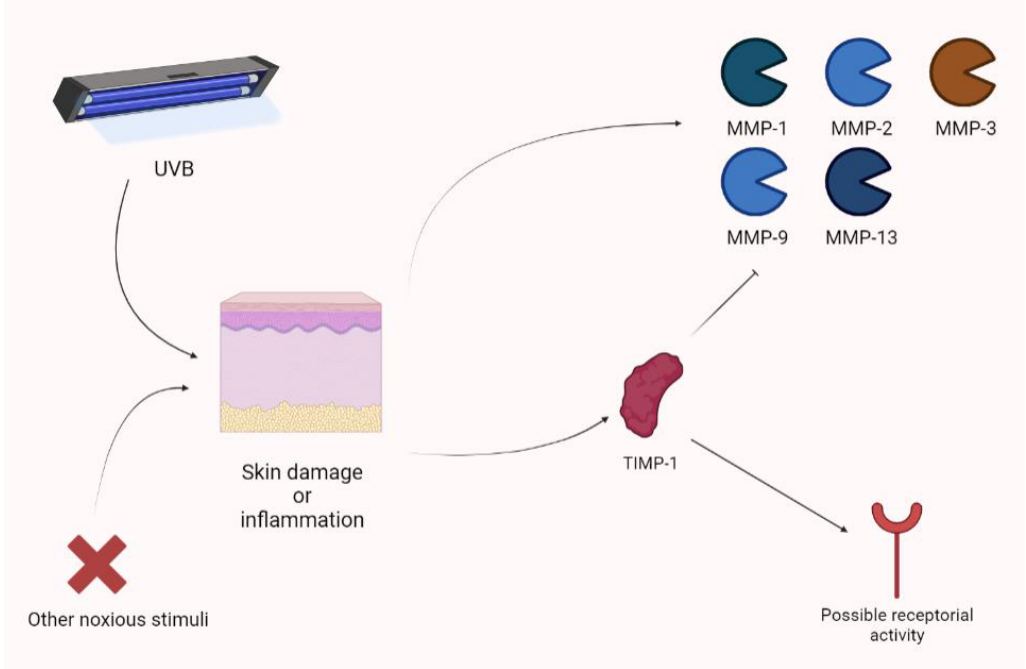
Figure 9. Cutaneous inflammation or damage is characterized by the raise of different MMP isoforms after UVB damage. Nevertheless, TIMP-1 seems to be overexpressed and to act as a regu- lator, not only thorough MMP inhibition, but also showing receptor-based activity. UVB, ultraviolet